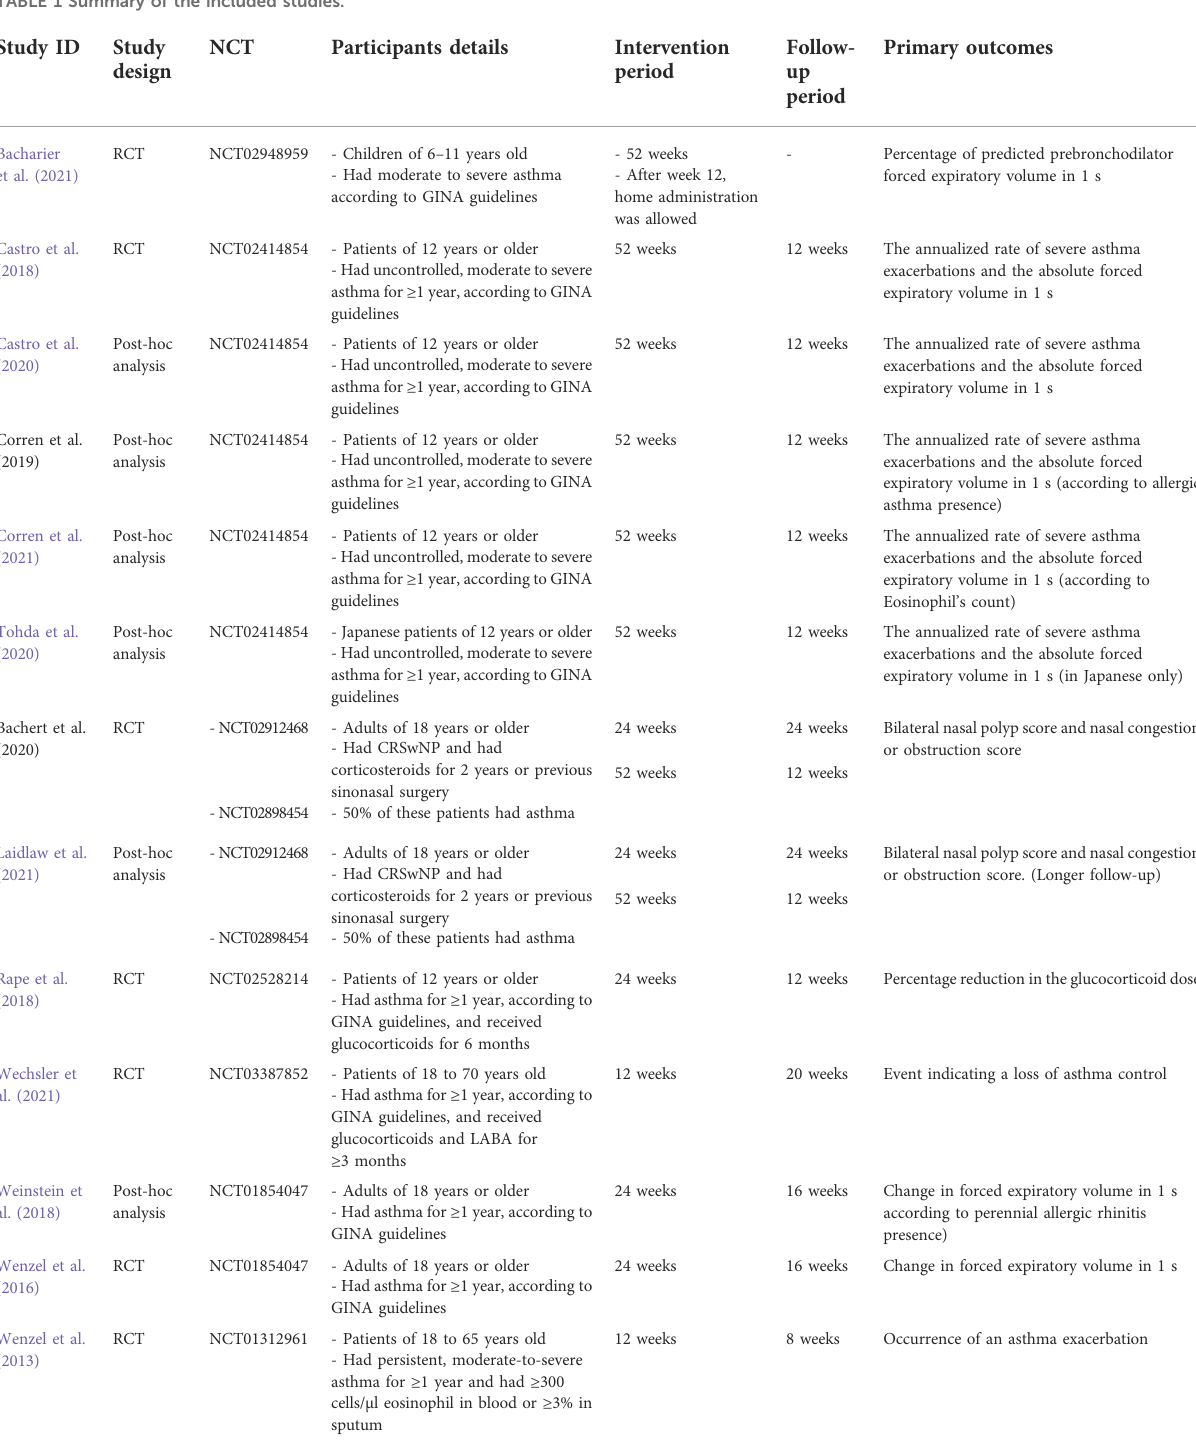
TABLE 1 Summary of the included